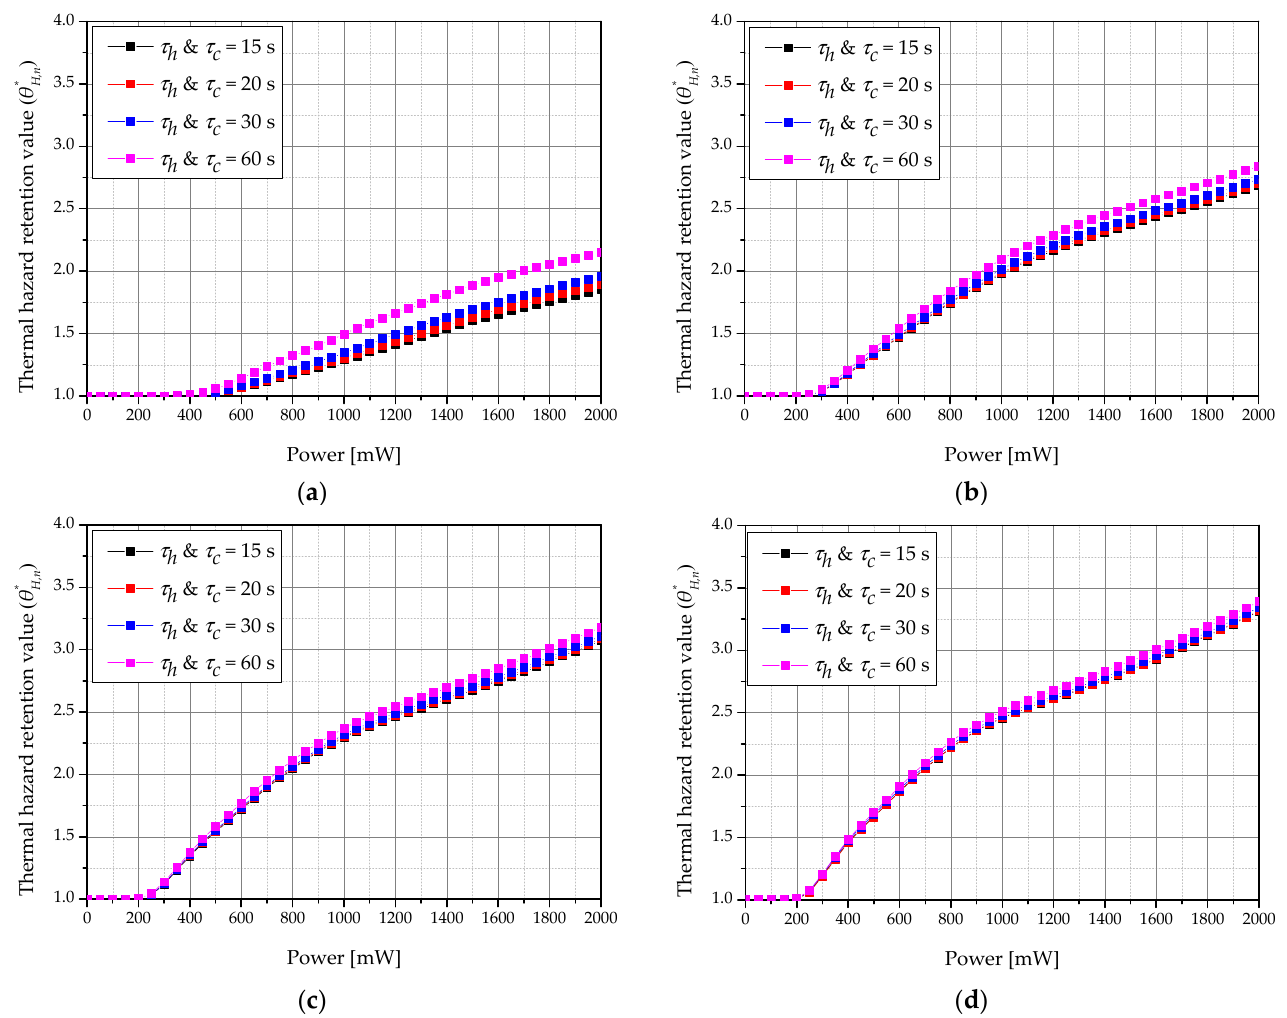
Figure 12. Thermal hazard retention value of normal tissue ( θ ∗ ) for various heating/cooling time ( τ h and τ c ) ( f v = 10 − 6 ). ( a ) τ tot = 120 s; ( b ) τ tot = 360 s; ( c ) τ tot = 600 s; ( d ) τ tot = 840 s.